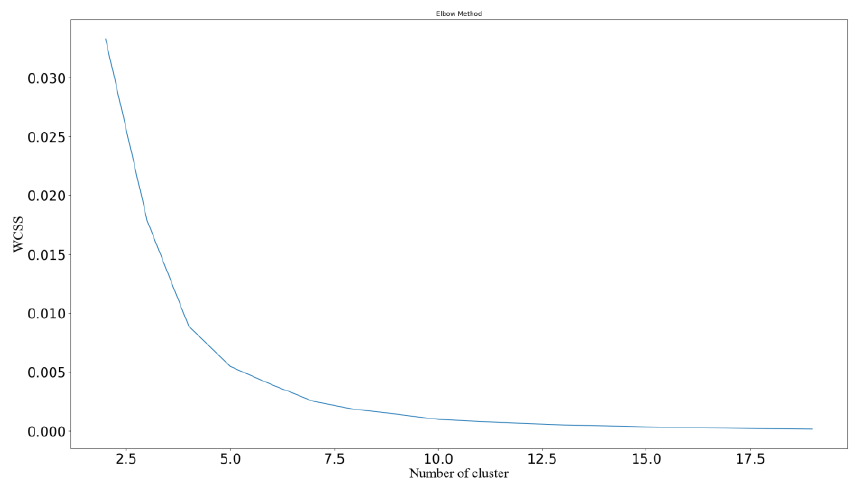
Figure 5. The results of the elbow method.